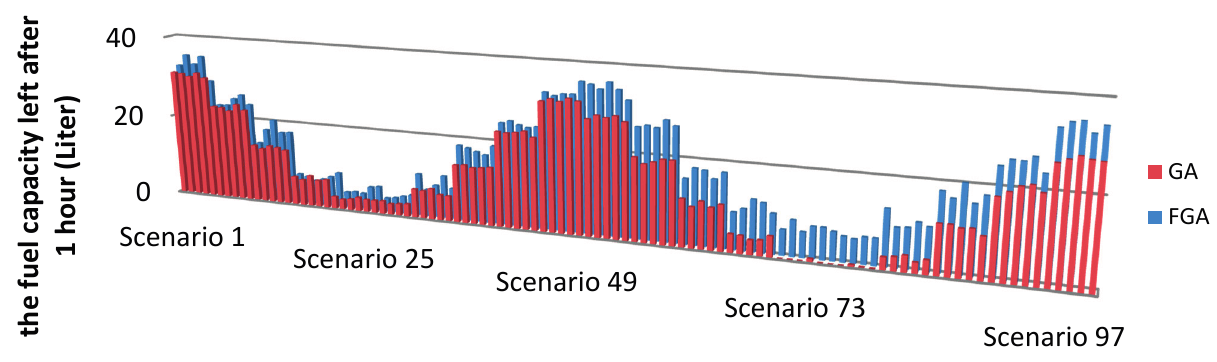
Figure 2. Fuel capacity after one hour (100 scenarios in